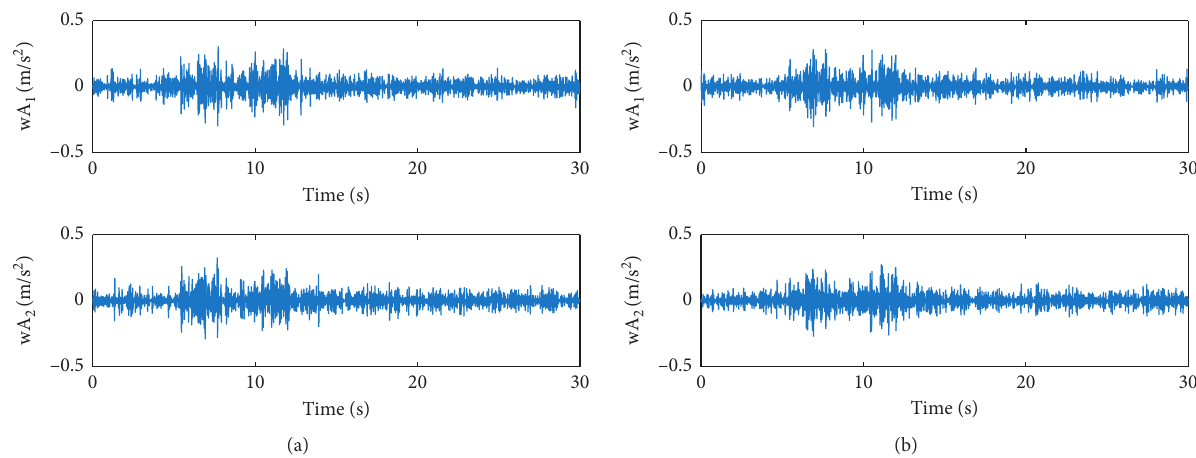
Figure 13: Wavelet detailed components of the simulated structure under Kobe earthquake wave. (a) Case 1. (b) Case